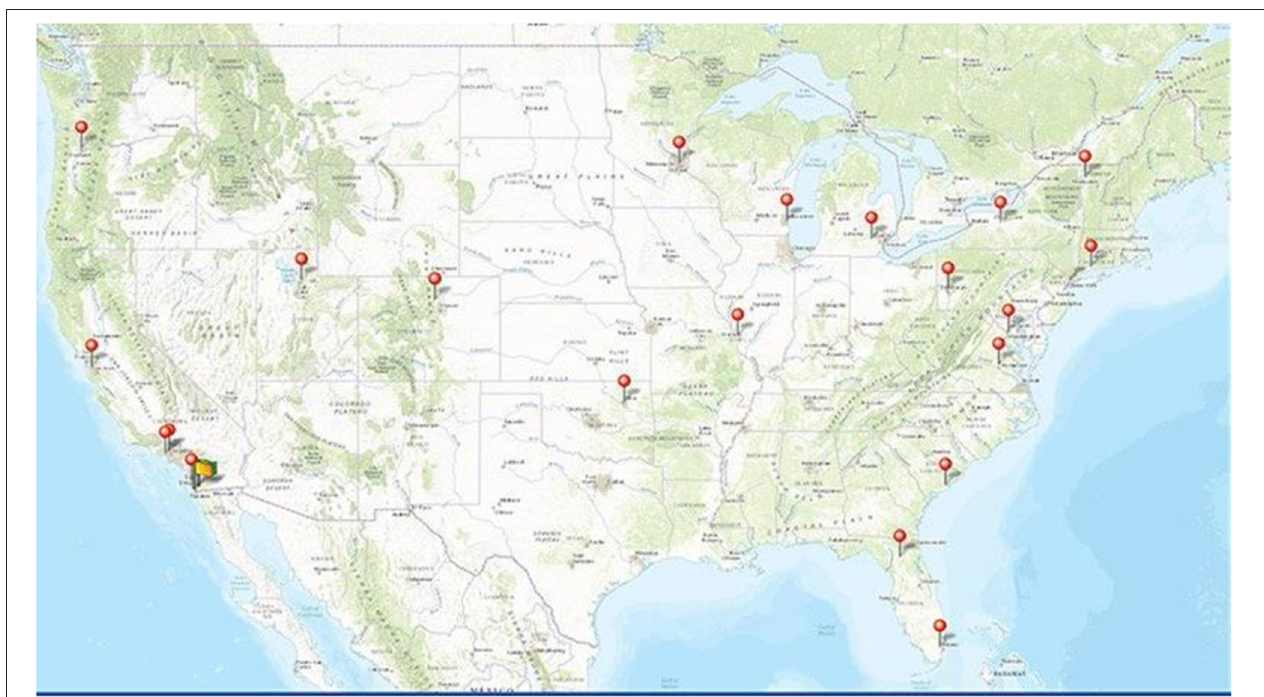
FIGURE 1 | Map showing the 21 collection sites across the United States for the ABCD